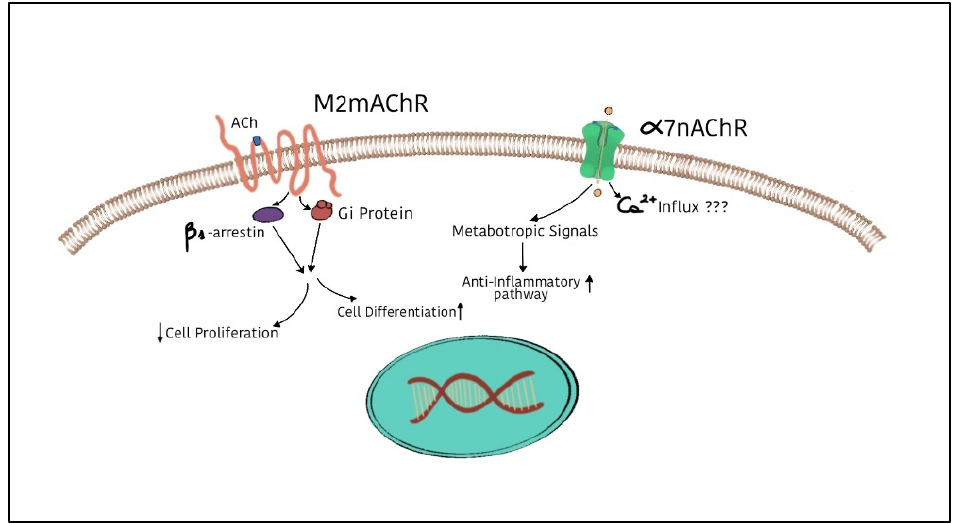
Figure 2. Schematic representation of the effects mediated by M2 muscarinic receptors and α 7 nicotinic receptors on Schwann cells during SC development or after nerve damage, respectively. Metabotropic signals downstream of M2 receptor activation inhibit SC proliferation and promote their differentiation. However, α 7 nicotinic receptors, expressed by SCs after peripheral fiber injury, contribute to modulating the anti-inflammatory pathway, thus restoring cell